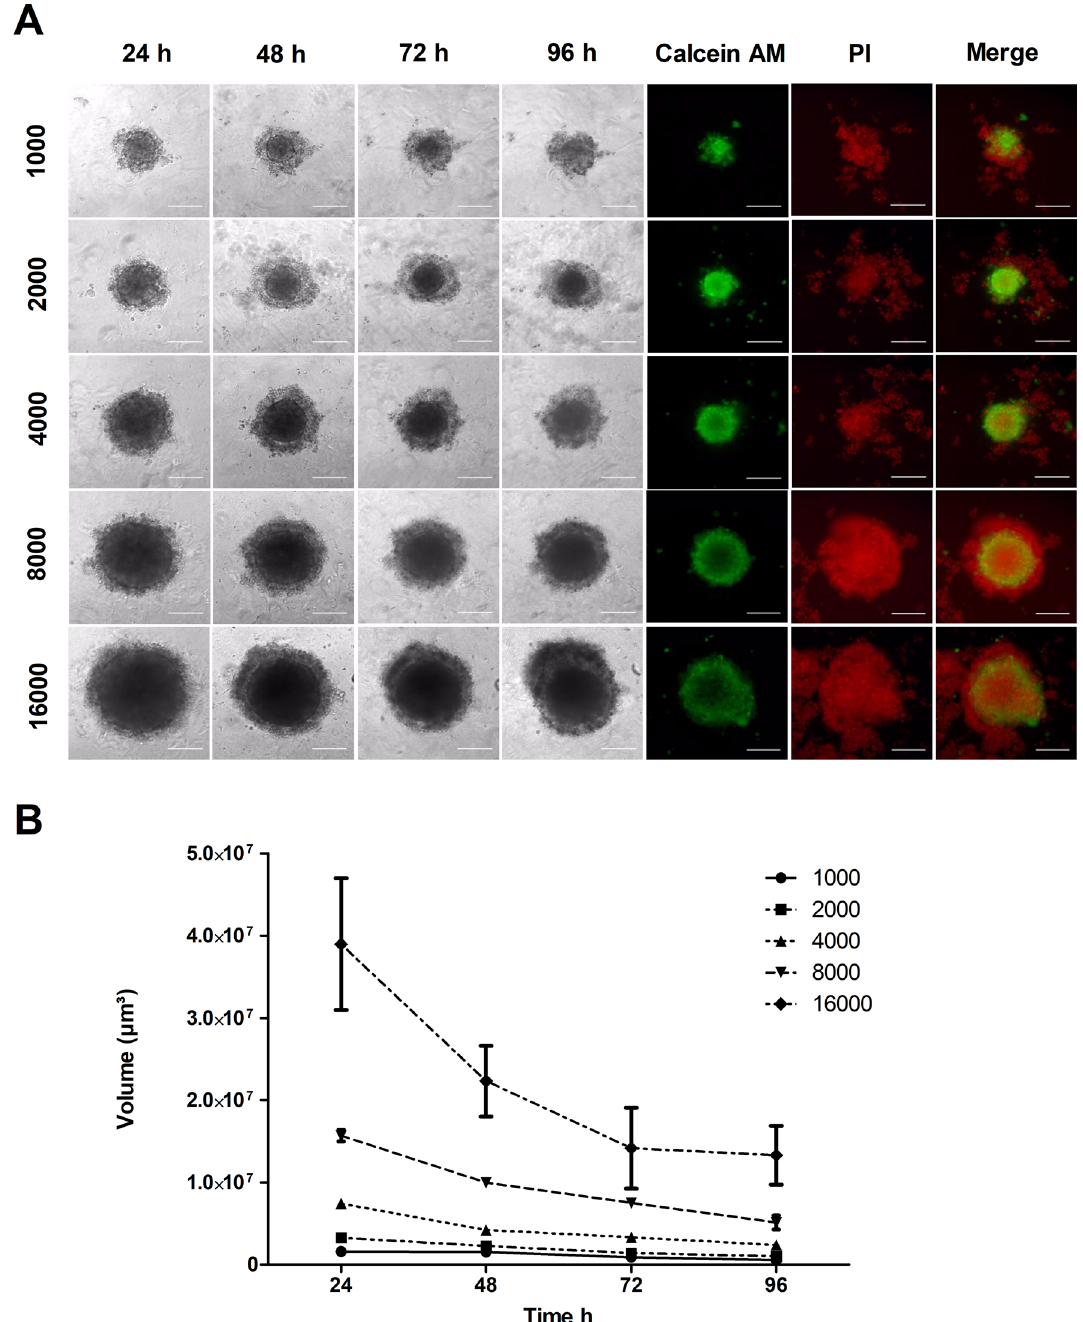
Figure 5. MaS-3 cell line can grow in 3D as spheroids. ( A ) Spheroids were obtained with seeding different cell densities of MaS-3. Post 96 h live/dead staining with calcein AM (green), ethidium homodimer-1 (red) and merged was performed. Flurosent images were taken with ×10 magnification on a DM IRB Leica microscope. Scale bars denote 200 µm. ( B ) Volume curve for MaS-3 spheroids over time. Experiment was performed in triplicates error bars denote standard error of